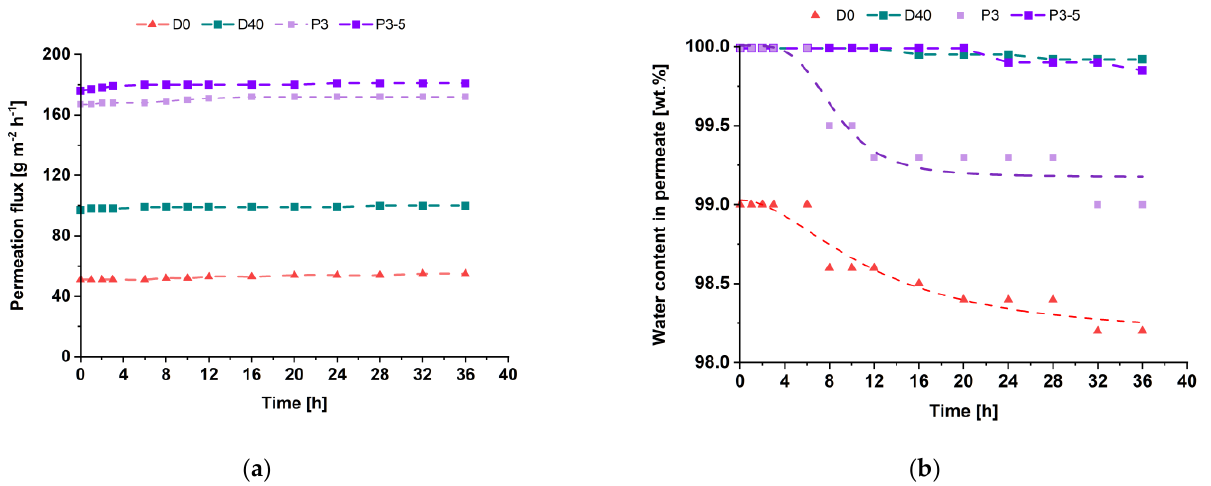
Figure 13. The long-term performance of the D0, D40, P3 and P3-5 membranes in pervaporation of 88 wt.% isopropanol/12 wt.% water mixture at 25 °C: ( a ) — permeation flux, ( b ) — water content in permeate.